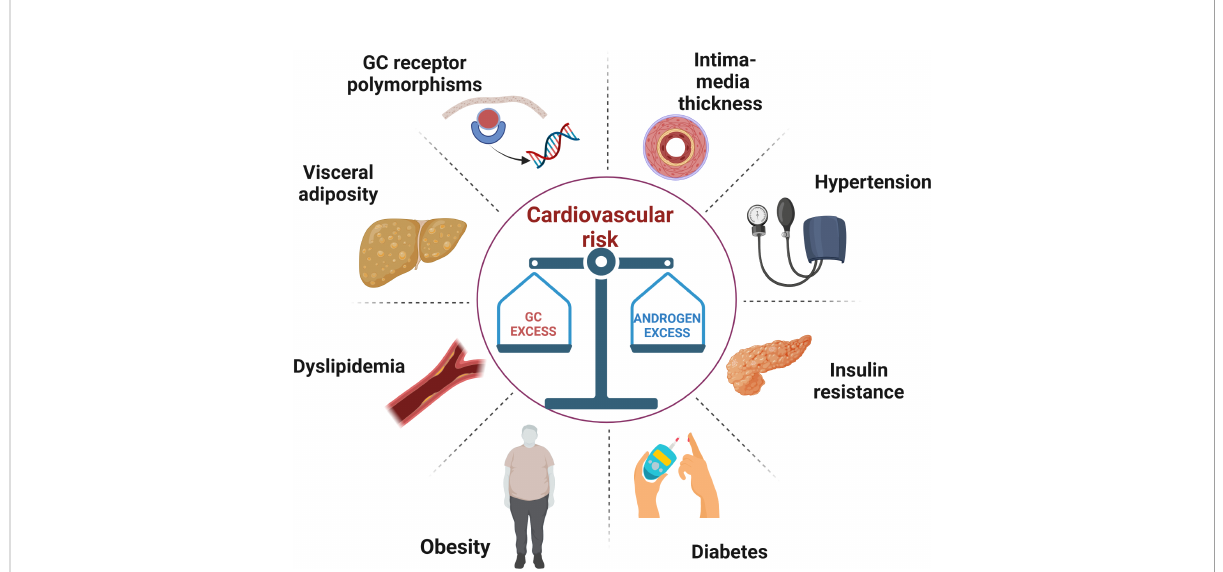
FIGURE 1 A schematic illustration of the metabolic and vascular complications caused by the dif fi cult balance between glucocorticoid overtreatment and androgen excess in congenital adrenal hyperplasia. GC,